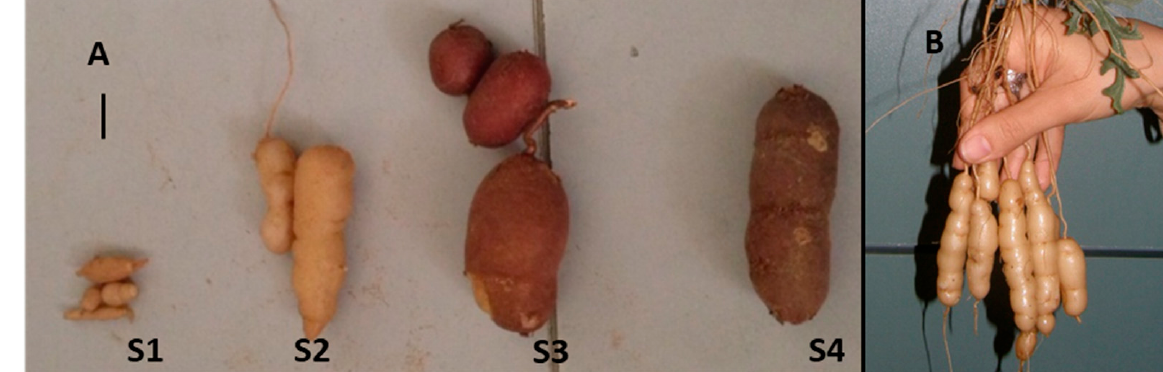
Figure 1. Age-related changes in size and morphology of harvested HSB tubers ( A ): S1—very young, small tubers; S2—young, fully grown tubers; S3—mature tubers with suberized skin; S4—an old, deep brown tuber. Bar indicates 1 cm. A typical beady elongated HSB tubers harvested from irrigated plots ( B ).